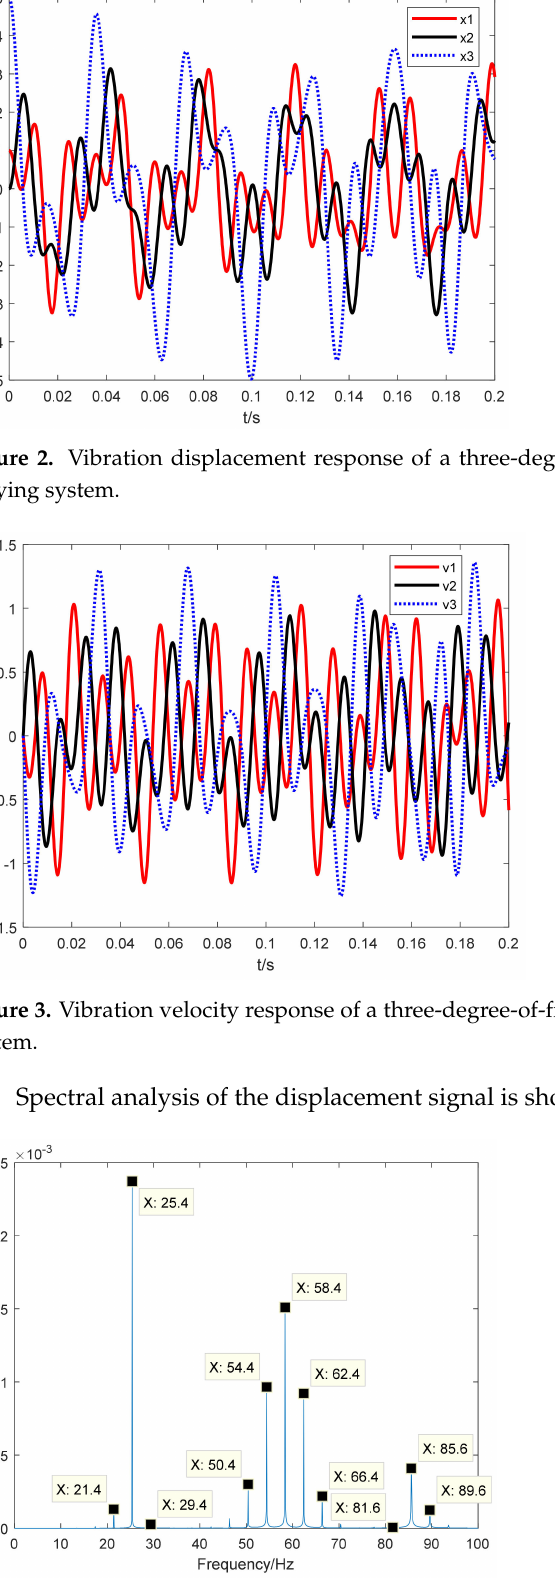
Figure 4. A three-degree-of-freedom stiffness periodically time-varying system vibration displace- ment